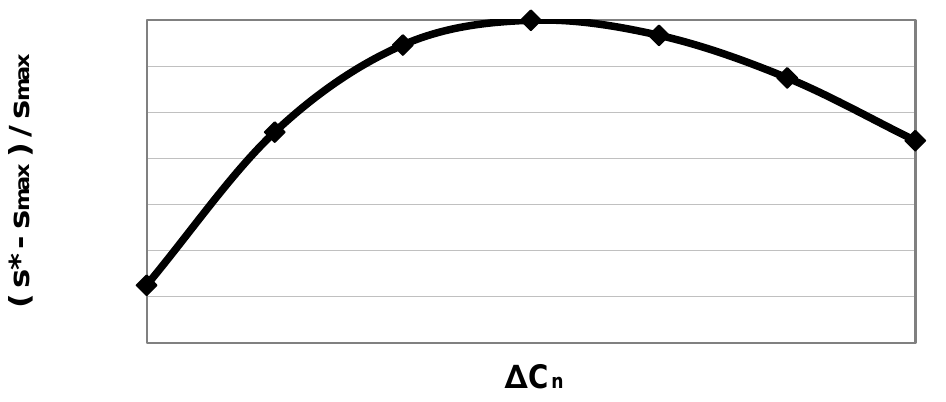
Figure 4. Sensitivity analysis on deviations to optimal average speed from variations congestion parameter C